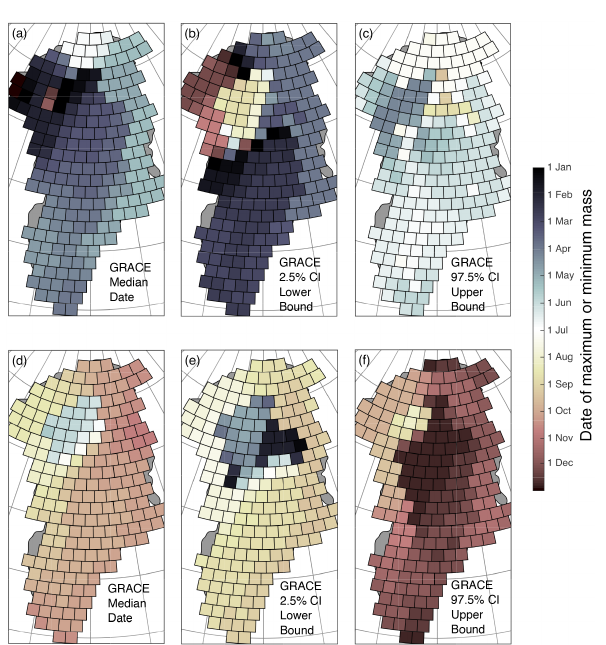
Figure 9. Timing of peaks in the average January 2003–December 2012 seasonal cycle of detrended cumulative mass from GRACE- LM. (a) Dates of maximum mass for each mascon from the me- dian of the distribution from GRACE-LM, (b) the 2.5% limit on the distribution of maximum mass dates, and (c) the 97.5% limit. (d) Dates of minimum mass for each mascon, and (e) the 2.5% and (f) 97.5% limits. Ten days have been subtracted (added) to the lower (upper) bound on the distributions to account for potential errors associated with temporal